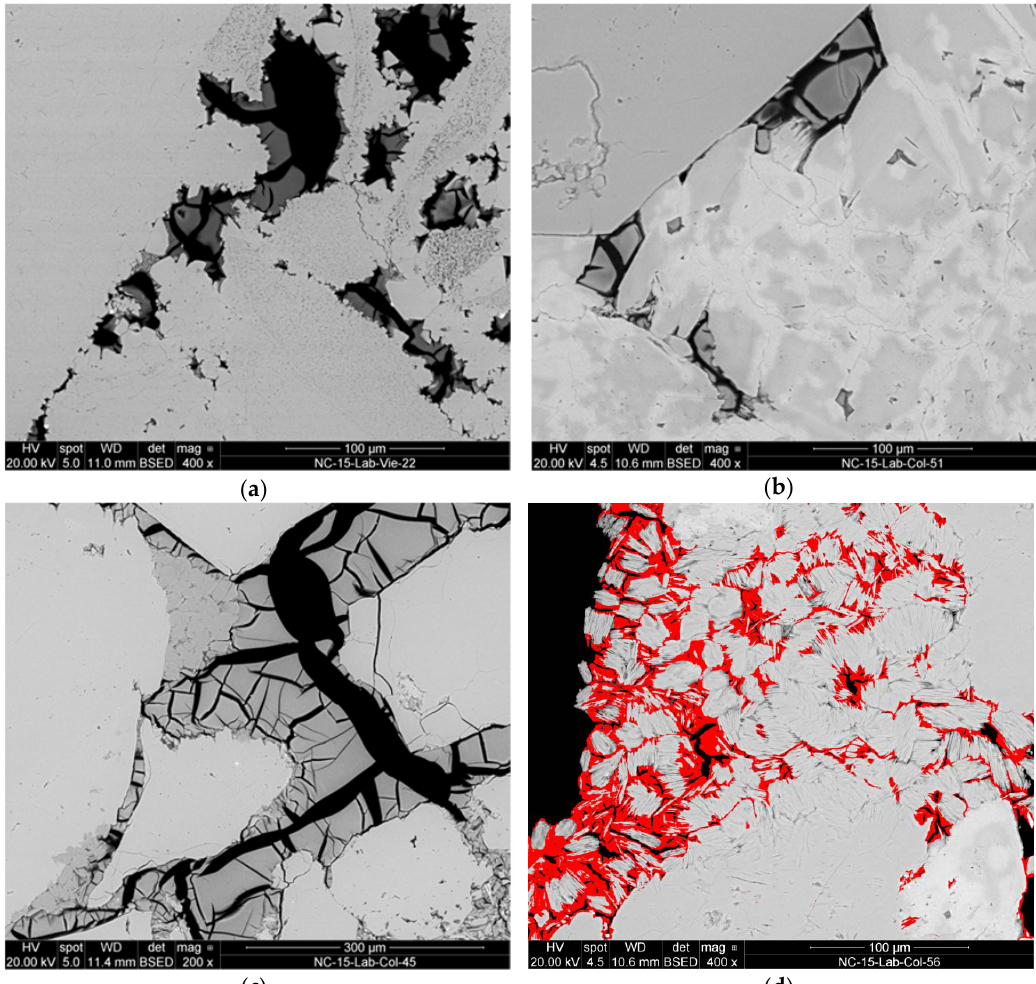
Figure 2. SEM-micrographs displaying some characteristic features of silica gels precipitated from various silicate treatments (gels are clearly visible by their grey value): ( a ) the adhesion of KSE 300 gel to St. Margarethen Limestone due to the advantageous topography of the grain boundary, ( b ) worse adhesion of KSE 300 gel to Schlaitdorf sandstone, ( c ) the shrinkage of NC ‐ 25C gel in intergranular pores of Schlaitdorf Sandstone, and ( d ) the interpenetration of the NC ‐ 27CP gel (shown in pseudo ‐ colour ‐ imaging) into the clayey matrix of Schlaitdorf Sandstone.